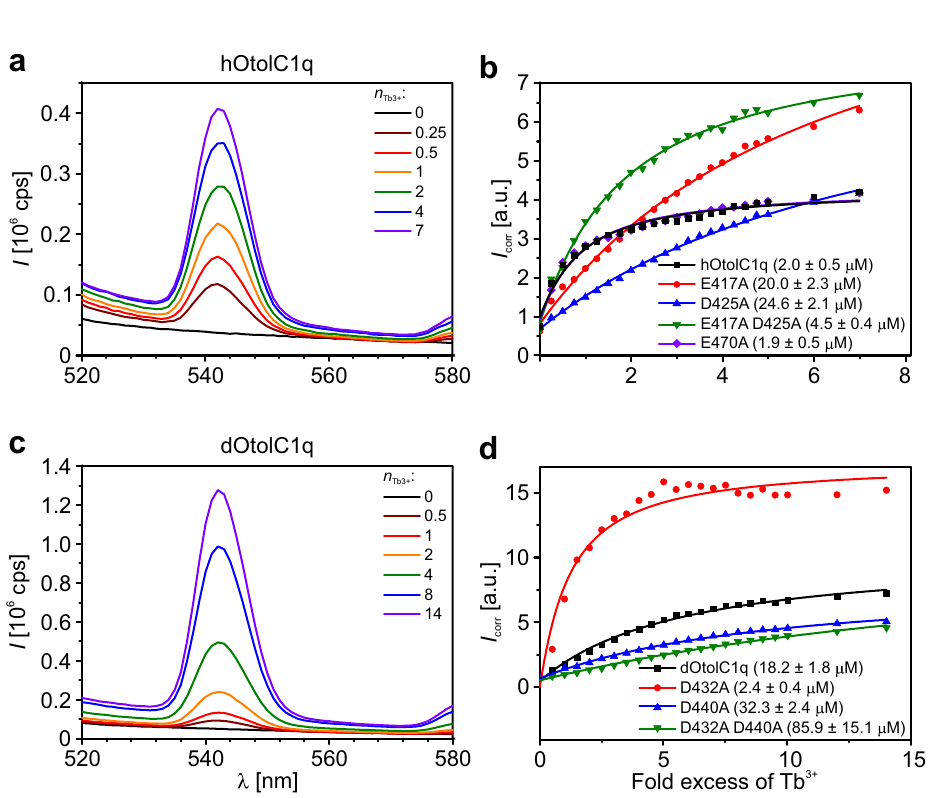
Figure 2. Binding of Tb 3+ by hOtolC1q, dOtolC1q and their mutants. ( a ) Effect of Tb 3+ (molar fold excess indicated as n Tb3+ ) on the emission spectrum of hOtolC1q excited at 280 nm. ( b ) Binding curves obtained for hOtolC1q and its mutants. ( c ) Effect of Tb 3+ on the emission spectrum of dOtolC1q excited at 280 nm. ( d ) Binding curves obtained for dOtolC1q and its mutants. Apparent dissociation constants are given in parentheses. Protein concentration was 3.7 µM in all experiments. After adding aliquots of TbCl 3 stock, the samples were incubated for 15 min before measuring the fluorescence emission intensity ( I ) from 520 to 580 nm at 1 nm/s. For calculations, the fluorescence intensity was standardized ( I corr ) by dividing I 545 by I 53070 . Apparent dissociation constants were calculated using a model of a single Tb 3+ binding site per gC1q otolin-1 monomer with Origin Pro